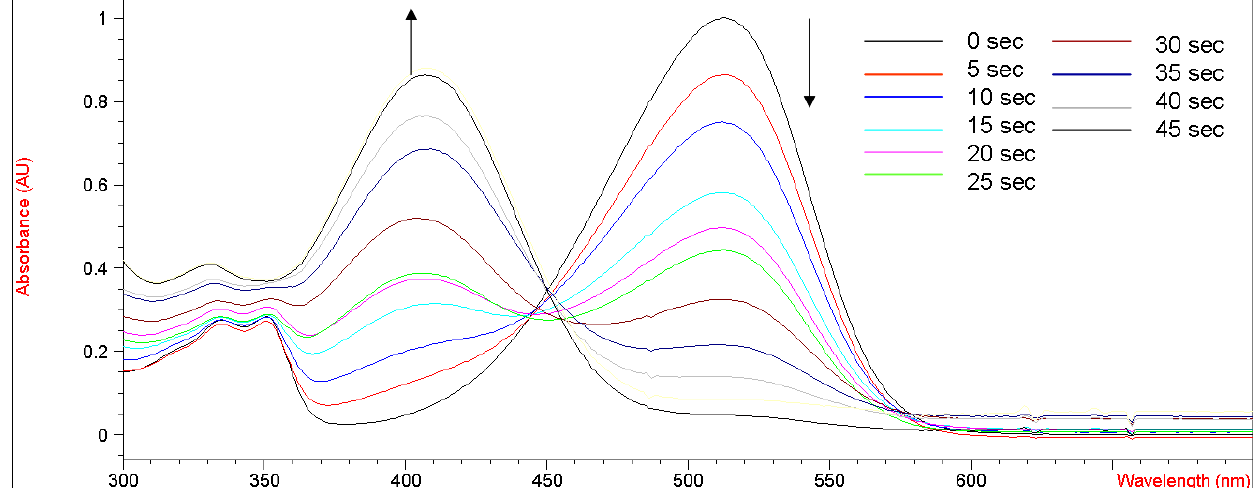
Cl ) with increasing 2 2